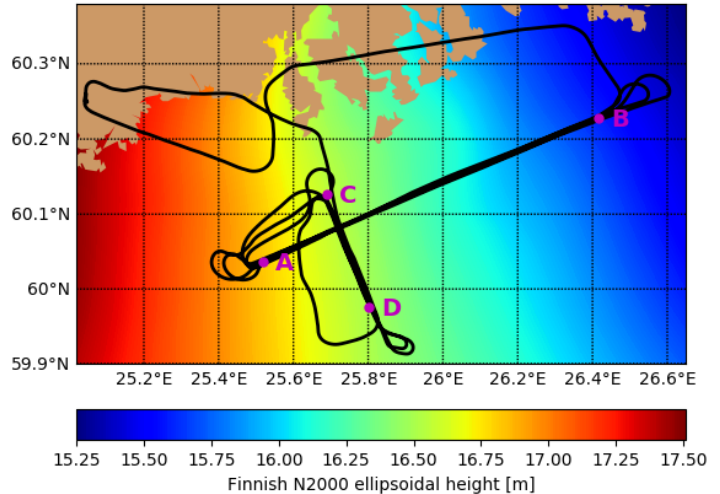
Figure 1. Flight path of the experimental campaign over the Baltic Sea. The background color of the sea indicates the ellipsoidal heights from Finnish N2000 system according to FIN2005N00 conversion surface [25]. The location of four reference waypoints (A, B, C and D) is